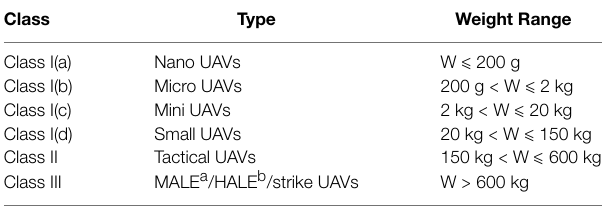
TABLE 1 | UAV classification based on weight according to Brooke-Holland (2012).